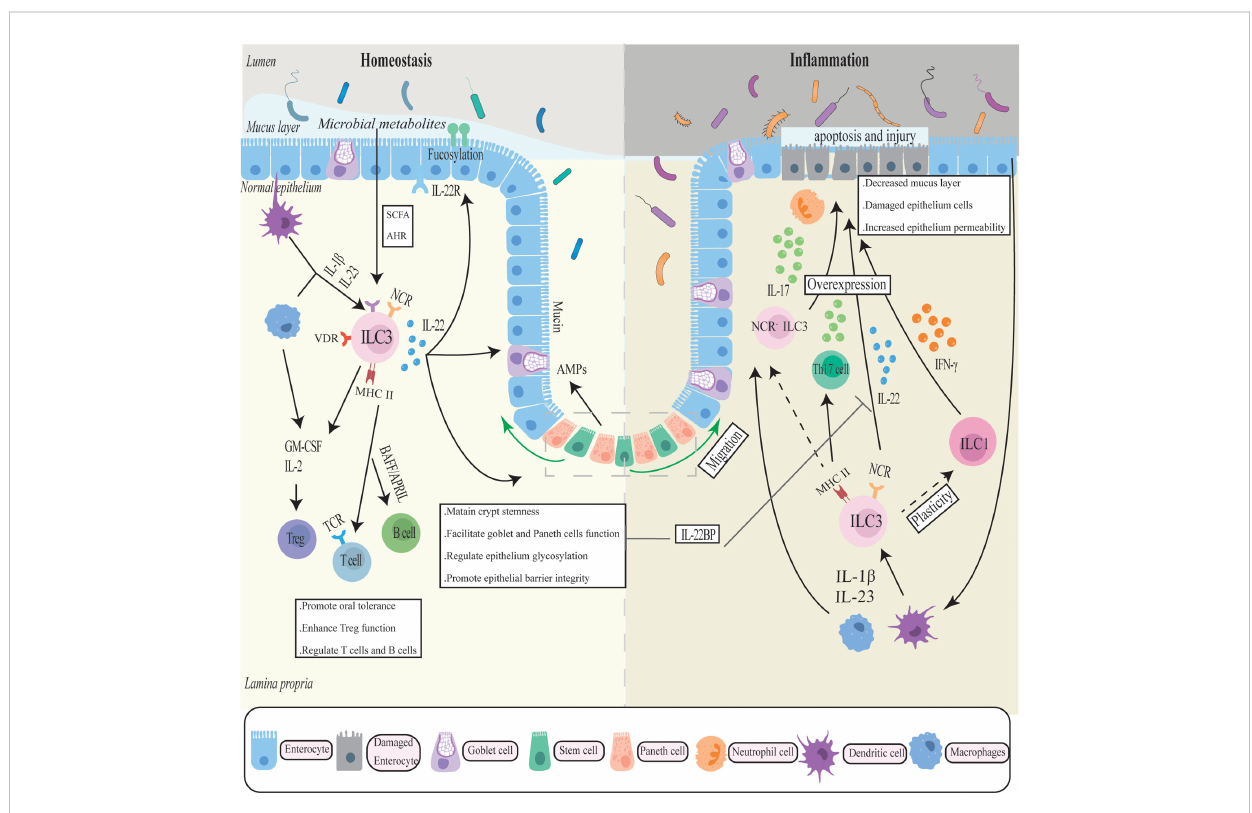
FIGURE 1 The complicated role of ILC3 in intestinal homeostasis and in fl ammation. ILC3 generates cytokines such as IL-17, IL-22, IFN- g , and GM-CSF in response to cytokine stimulation by antigen-presenting cells such as macrophages to maintain the intestinal mucosal barrier. To regulate gut immune, ILC also interacts with a number of immune cells. In chronic in fl ammation, ILC3 may transfer into a pro-in fl ammatory phenotype and overexpress in fl ammatory factors, exacerbating intestinal in fl ammation and mucosal